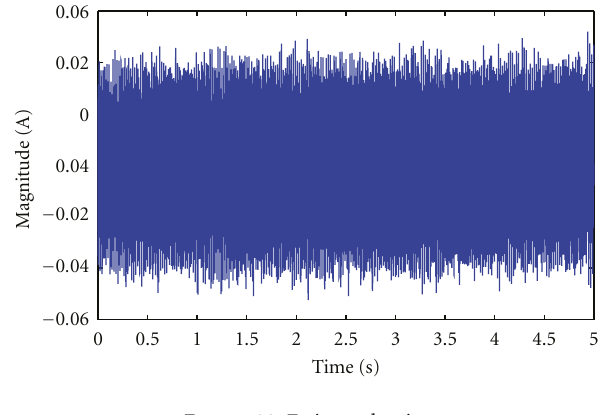
Figure 20: Estimated noise.